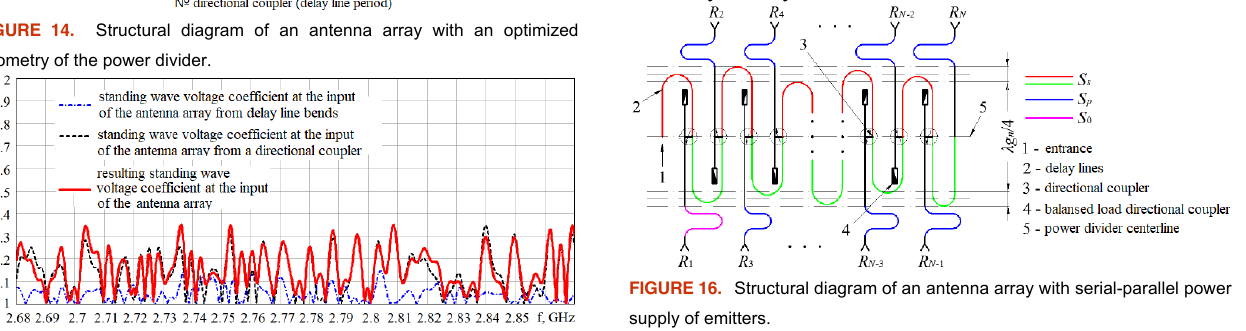
FIGURE 15. Standing wave ratio for voltage at the input of the antenna array after iterative optimization of the power divider geometry.